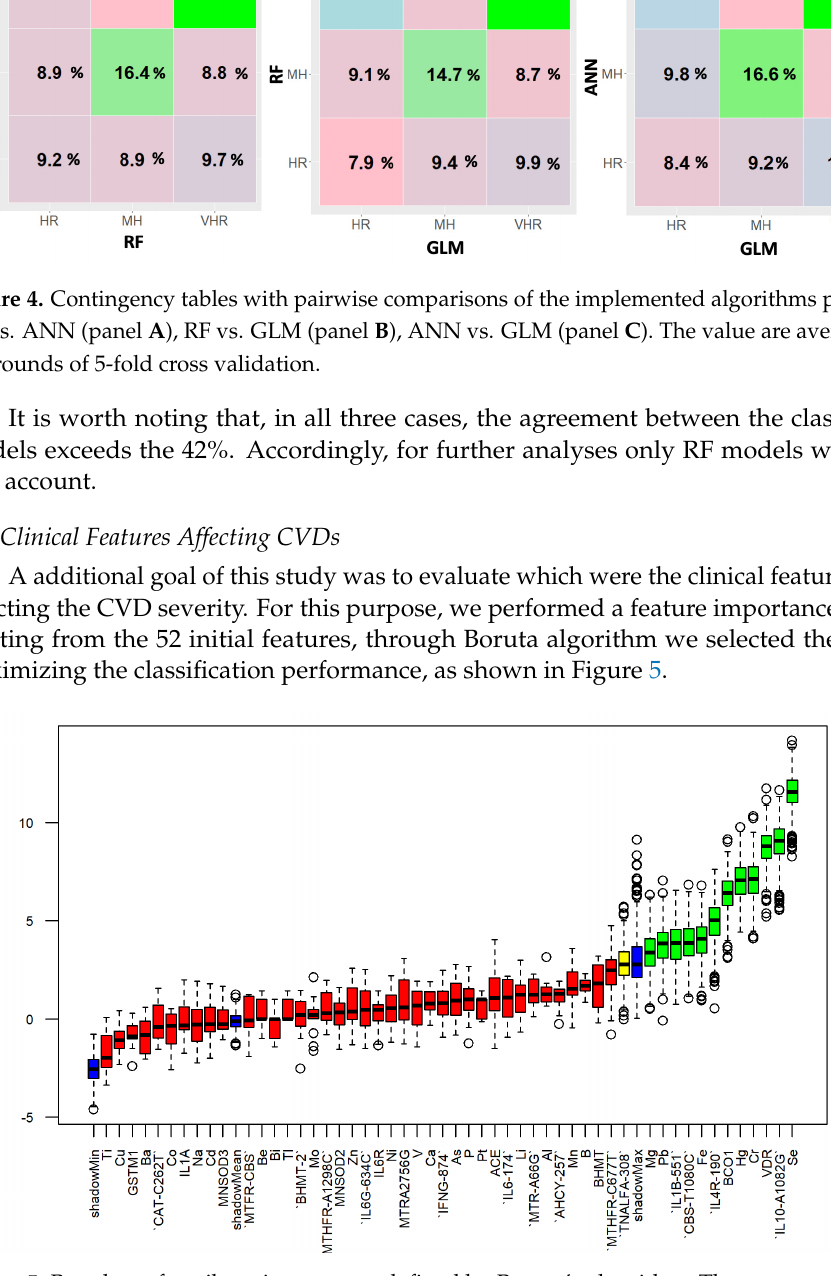
Figure 5. Boxplots of attribute importance defined by Boruta’s algorithm. The wrapper algorithm selects 13 important features (in green). The importance is computed in term of Z-score. Shadow Boruta predictors are shown in blue. Red colors indicate unimportant features, and yellow colors tentative attributes, i.e., features that are almost as important as their best shadow attributes and Boruta cannot make a decision about them with the desired confidence. Empty bullets represent the outliers of